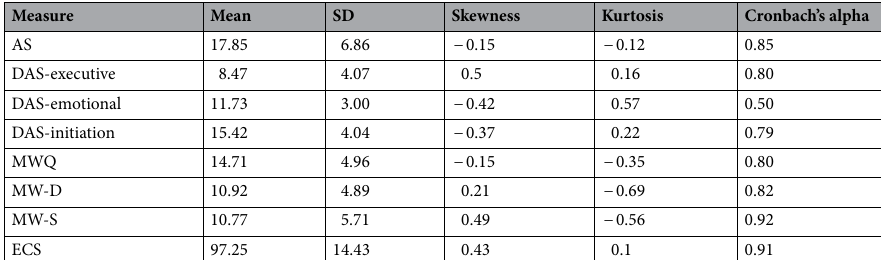
Table 2. Descriptive information of study 2 (N = 562). AS apathy scale, DAS dimensional apathy scale, MWQ mind wandering questionnaire, MW-D deliberate mind wandering scale, MW-S spontaneous mind wandering scale, SD standard deviation and ECS effortful control